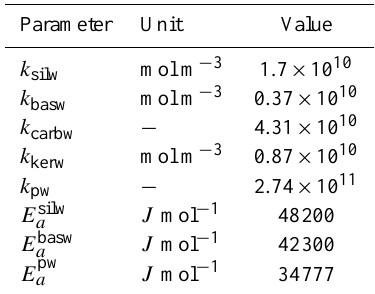
Table 2. Parameters used in the continental weathering module of GEOCLIM reloaded